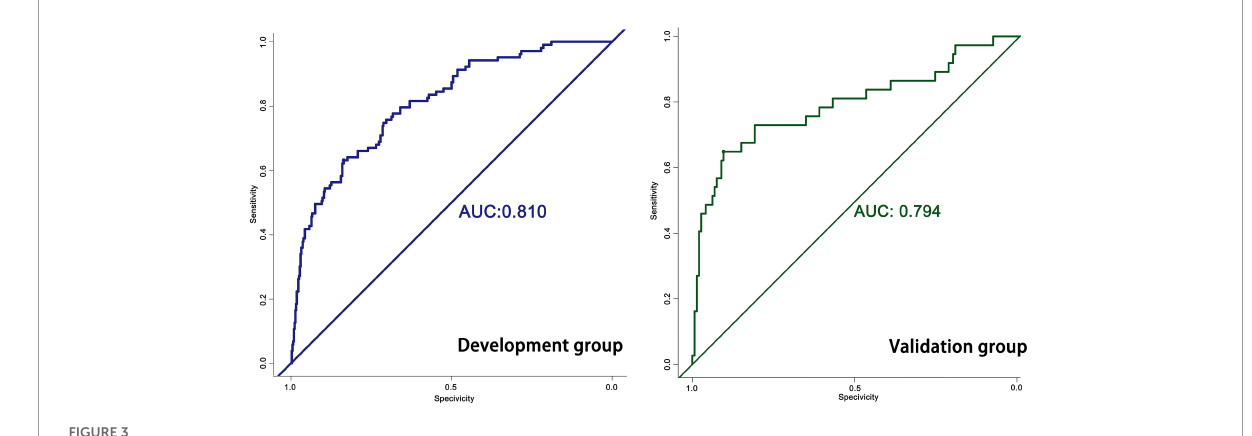
FIGURE3 The ROC of the nomogram.